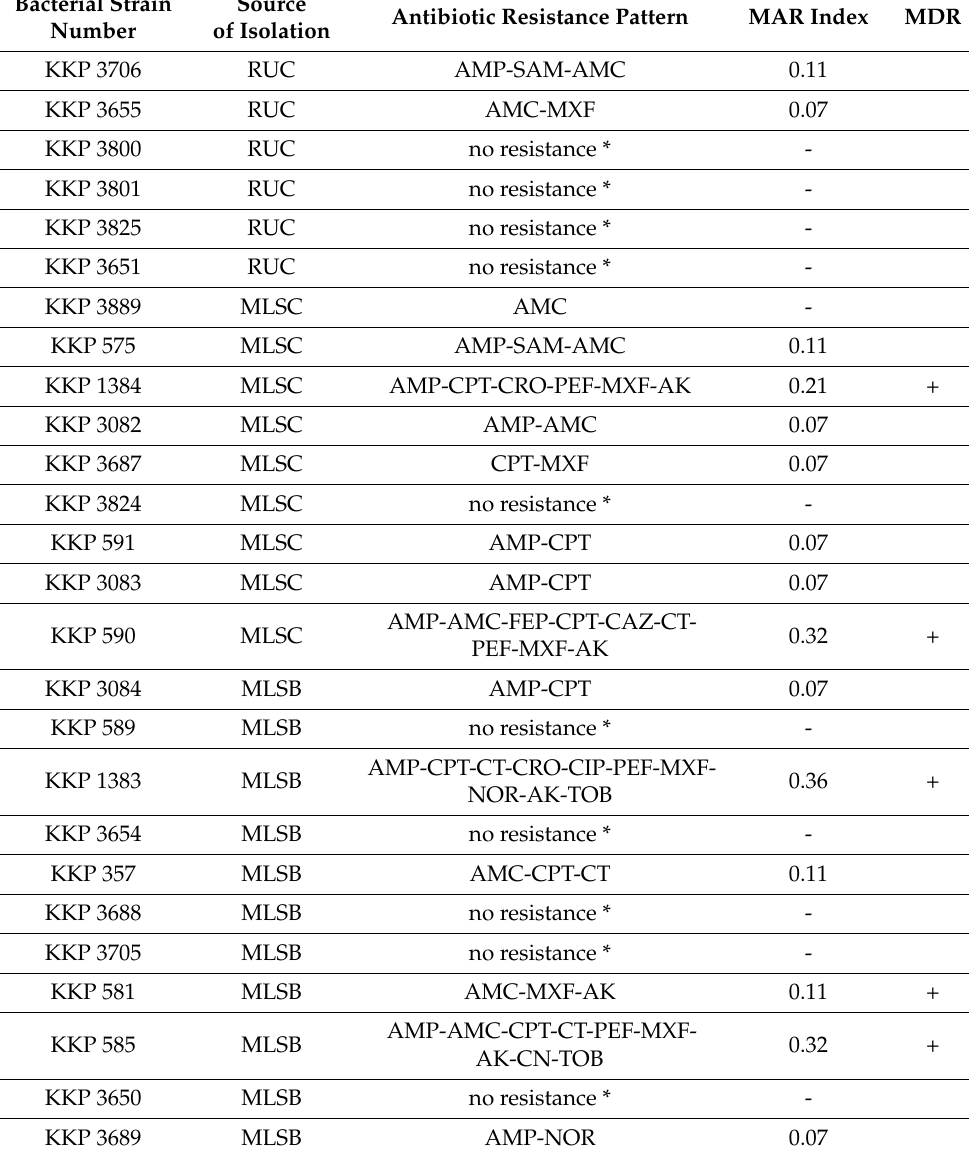
Table 3. Phenotype resistance of bacterial strains. Bacterial Strain Number